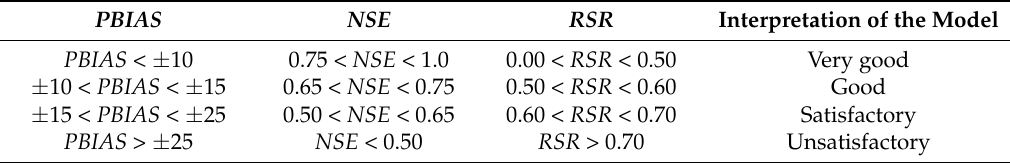
Table 1. Interpretation of statistical parameters for calibration and validation [33]. PBIAS NSE RSR Interpretation of the